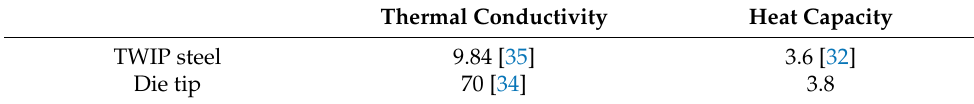
Figure 4. True stress–strain curve of the hot-rolled TWIP steel. Table 1. Thermal properties of wire and die used in this